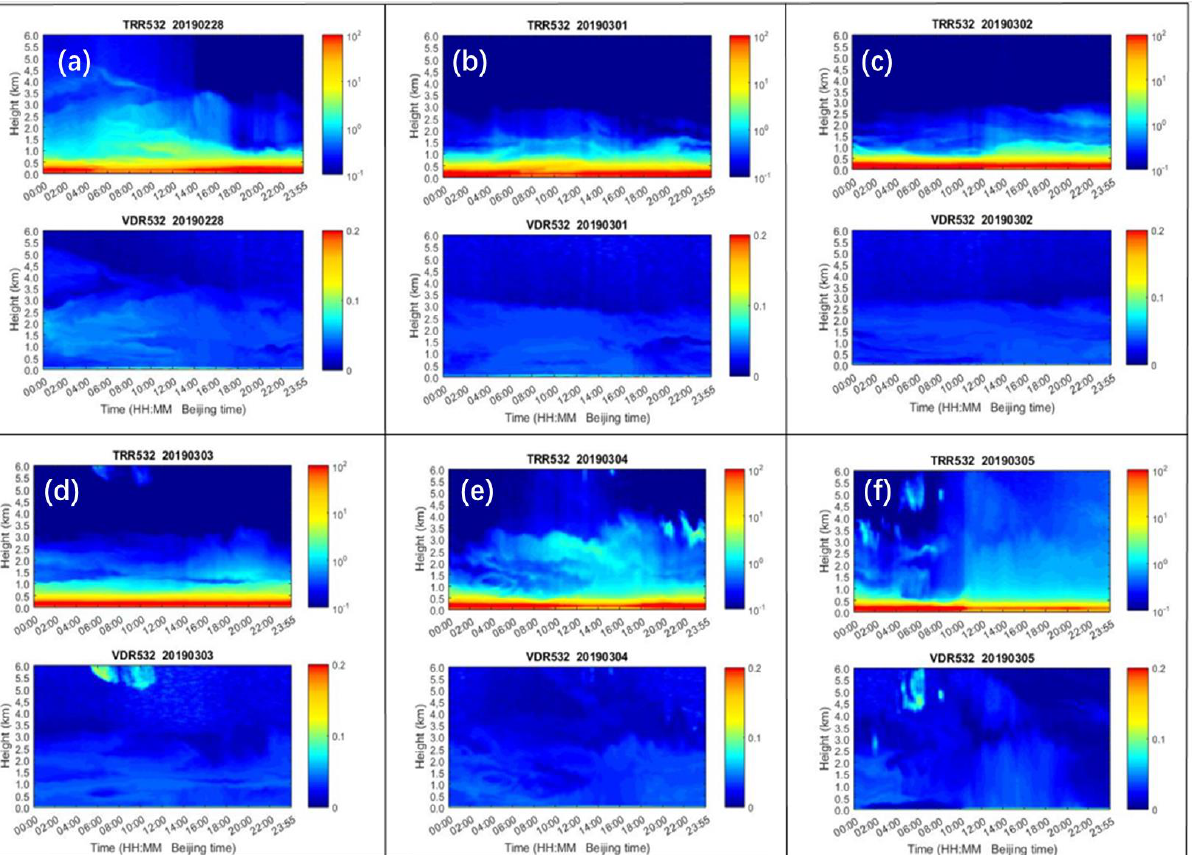
Figure 1. Range correction signal (TRR, the upper) and the volume depolarization ratio (VDR, the lower) from 28 February to 5 March